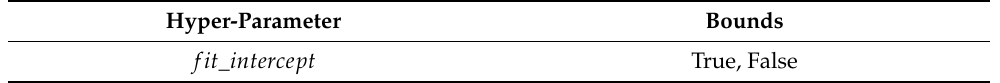
Table 9. An overview of the used hyper-parameter range for Linear Regression Algorithm.